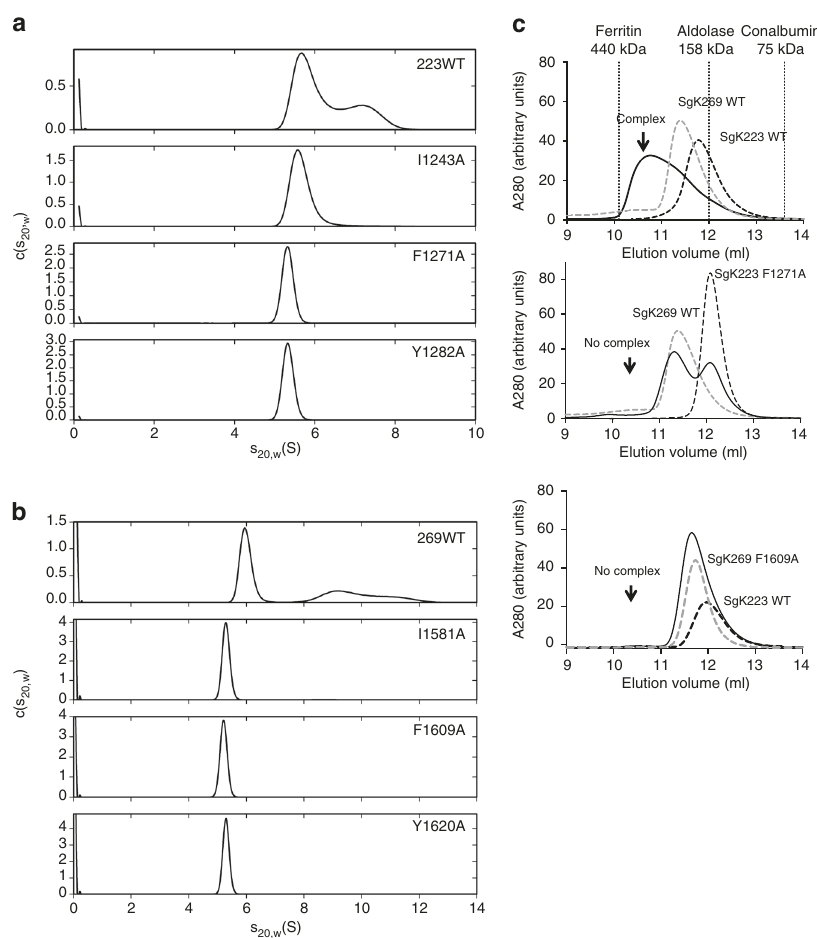
Fig. 6 Characterization of SgK223 and SgK269 oligomerization interface. a c ( s 20,w ) distributions for SgK223- α N1-PsK-Cter (WT) and mutants at the oligomeric interface, each analysed at a concentration of 20.0 μ M, where the WT protein displays signi fi cant formation of oligomers larger than dimer. b c ( s 20,w ) distributions for SgK269- α N1-PsK-Cter (WT) and mutants at the oligomeric interface, each analysed at a concentration of 20.0 μ M, where the WT protein displays signi fi cant formation of oligomers larger than dimer. c Size-exclusion chromatography analysis (Superdex 200 TM Increase 10/300 GL, GE Healthcare) of SgK223 and SgK269 complex. Incubation of SgK223- α N1-PsK-Cter (WT) with SgK269- α N1-PsK-Cter (WT) at 1:1 ratio results in a complex formation (top). Incubation of SgK223- α N1-PsK-Cter F1271A mutant with SgK269- α N1-PsK-Cter (WT) does not form a complex (middle). Incubation of SgK269- α N1-PsK-Cter F1609A mutant with SgK223- α N1-PsK-Cter (WT) does not form a complex (bottom). SgK223- α N1-PsK-Cter (WT) and mutants in black dashed lines; SgK269- α N1-PsK-Cter (WT) and mutants in grey dashed lines; complex of SgK223- α N1-PK-Cter and SgK269- α N1-PsK- Cter in black line. Elution volume of molecular weight standards Ferritin (440 kDa), Aldolase (158 kDa) and Conalbumin (75 kDa) is shown in vertical dotted lines. See also Supplementary